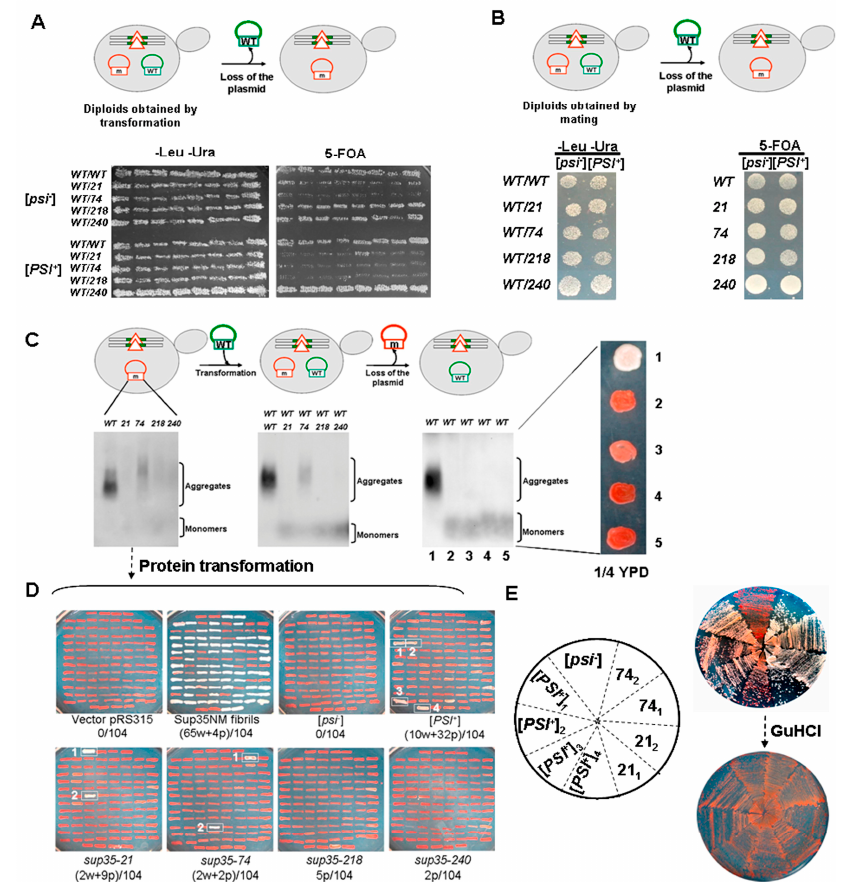
Figure 5. Lethality of the [ PSI + ] diploids depends on the technique used to obtain SUP35 / sup35-n cells. ( A ) Cells bearing sup35-n mutations are lethal in combination with the [ PSI + ] prion in diploid cells obtained by transformation. [ PSI + ] or [ psi − ] diploids containing plasmid with wild-type SUP35 were transformed with sup35-n mutant plasmids; growth of transformants was tested on the medium selective for both plasmids (left panel), then transformants were replica plated on 5-FOA media to select against SUP35 plasmid (right panel). Growth of eight independent transformants is shown after 7 days of incubation at 30 °C. ( B ) Cells bearing sup35-n mutations are viable in combination with the prion [ PSI + ] in diploid cells obtained by the mating of [ PSI + ] [ SUP35 ] strain with [ psi − ] [ sup35-n ] strains. Left panel represents the growth of diploids on the medium selective for both plasmids, right panel shows that all cells are able to lose SUP35 plasmid on 5-FOA media after 7 days of incubation at 30 °C. Eight independent transformants were tested in each case, representative results are shown. ( C ) The presence of sup35-n mutations leads to modification of [ PSI + ] aggregates properties in diploid strains. Left, cells selected on the Panel B contain only plasmid with mutation. Middle, these cells were transformed by SUP35 plasmid. Right, spontaneous loss of [ sup35-n LEU2 ] plasmid was performed. Lysates of cells bearing different plasmids were subjected to SDD-AGE followed by immunoblotting for Sup35. The right panel represents the growth of transformants bearing only SUP35 plasmid after loss of mutant plasmid on 1/4 YPD medium after 5 days of incubation at 30 °C. Numbers correspond to the lanes of the last SDD-AGE gel. ( D ) Infectivity of whole cell lysates of diploid strains D1691 [ psi − ], D1692 [ PSI + ] bearing SUP35 or sup35-n mutant plasmid (selected as shown on the Panel B), was determined by transformation into 1-OT56 [ psi − ] [ PIN + ]. Control transformation was performed with either vector pRS316 alone, or with fibrils of Sup35NM. Transformants were selected on SC-Ura media, and then patched on 1 / 4 YPD. In each case, growth of 104 independent transformants after 5 days of incubation at 30 ◦ C is shown. The number of white (w) or pink (p) clones is shown below. ( E ) White clones indicated by numbers on the Panel D were subcloned on 1 / 4 YPD followed by growth on GuHCl media and additional subcloning on 1 / 4